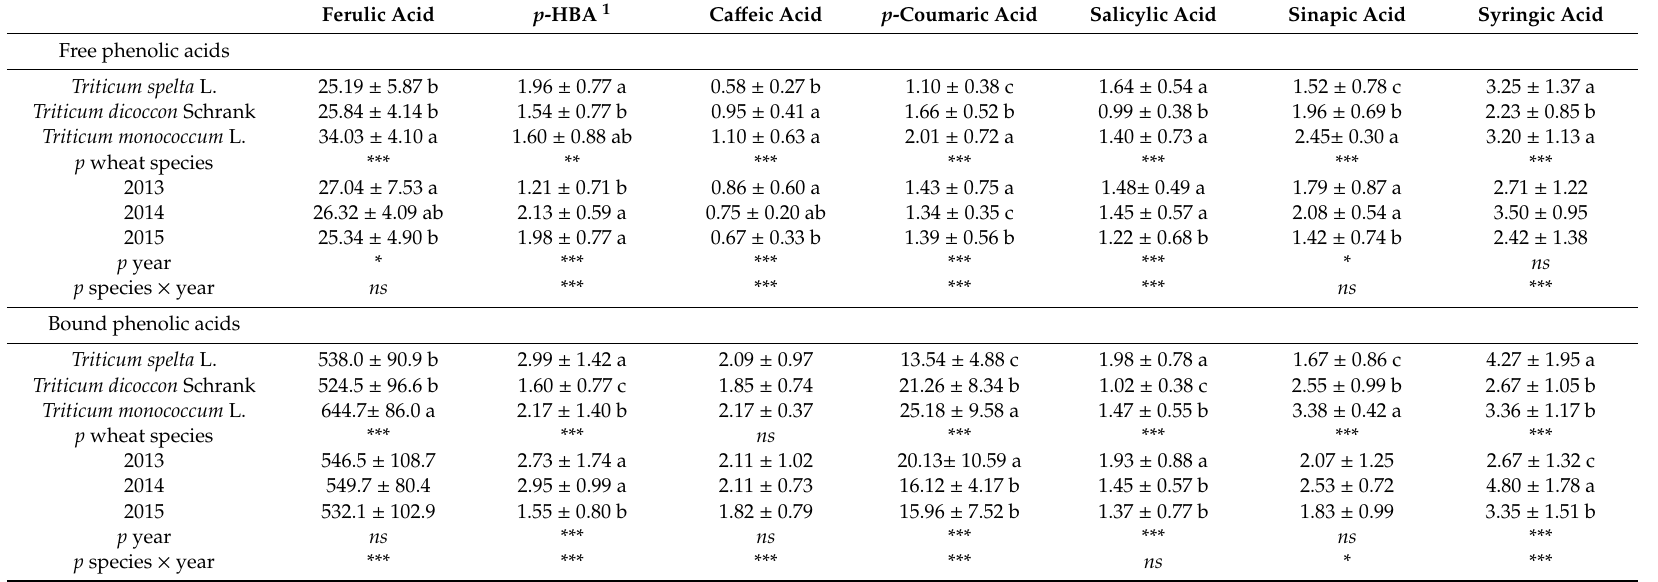
Table 3. E ff ect of wheat species and cultivation year on free and bound individual phenolic acids concentrations ( µ g / g dry mass) in whole grain flour. All values are means ± standard deviations for four experimental replicates. Values in rows (among species or year) followed by the same letter are not significantly di ff erent at p < 0.05. Main e ff ects and interaction F-test from two-way ANOVA at * p < 0.05, ** p < 0,01, *** p < 0.001, and ns —not significant.